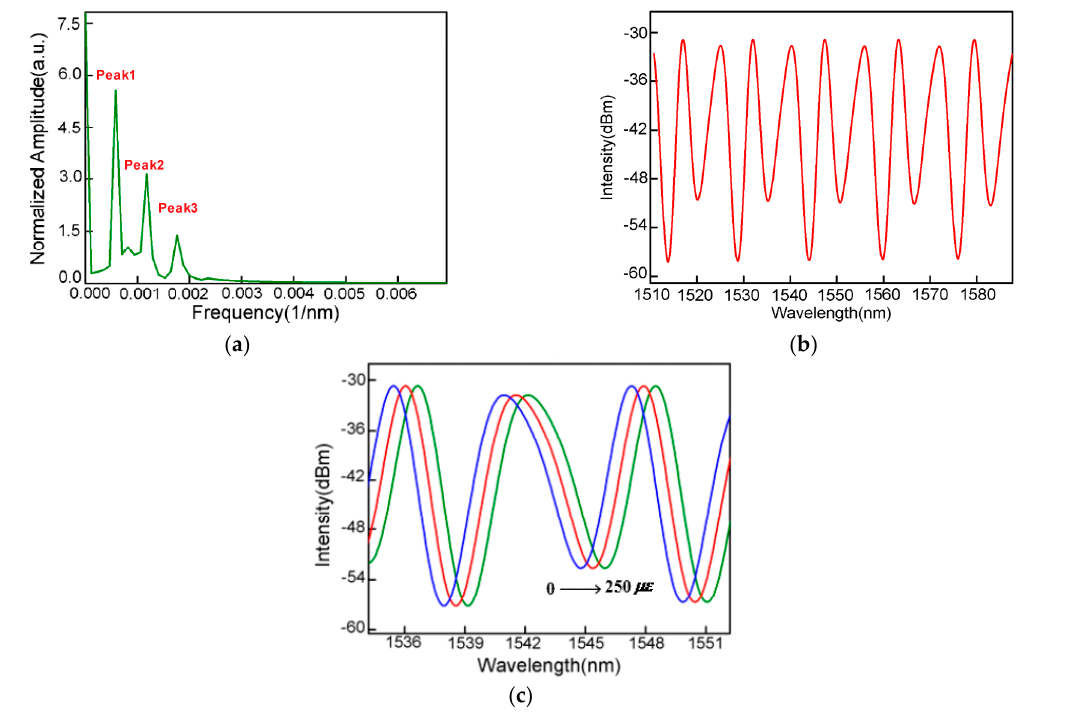
Figure 3. ( a ) Spatial frequency from the simulation result; ( b ) the simulated diagram of the interference pattern; ( c ) reflection spectrum evolution of the air-cavity–based FPI while the tensile strain increases.